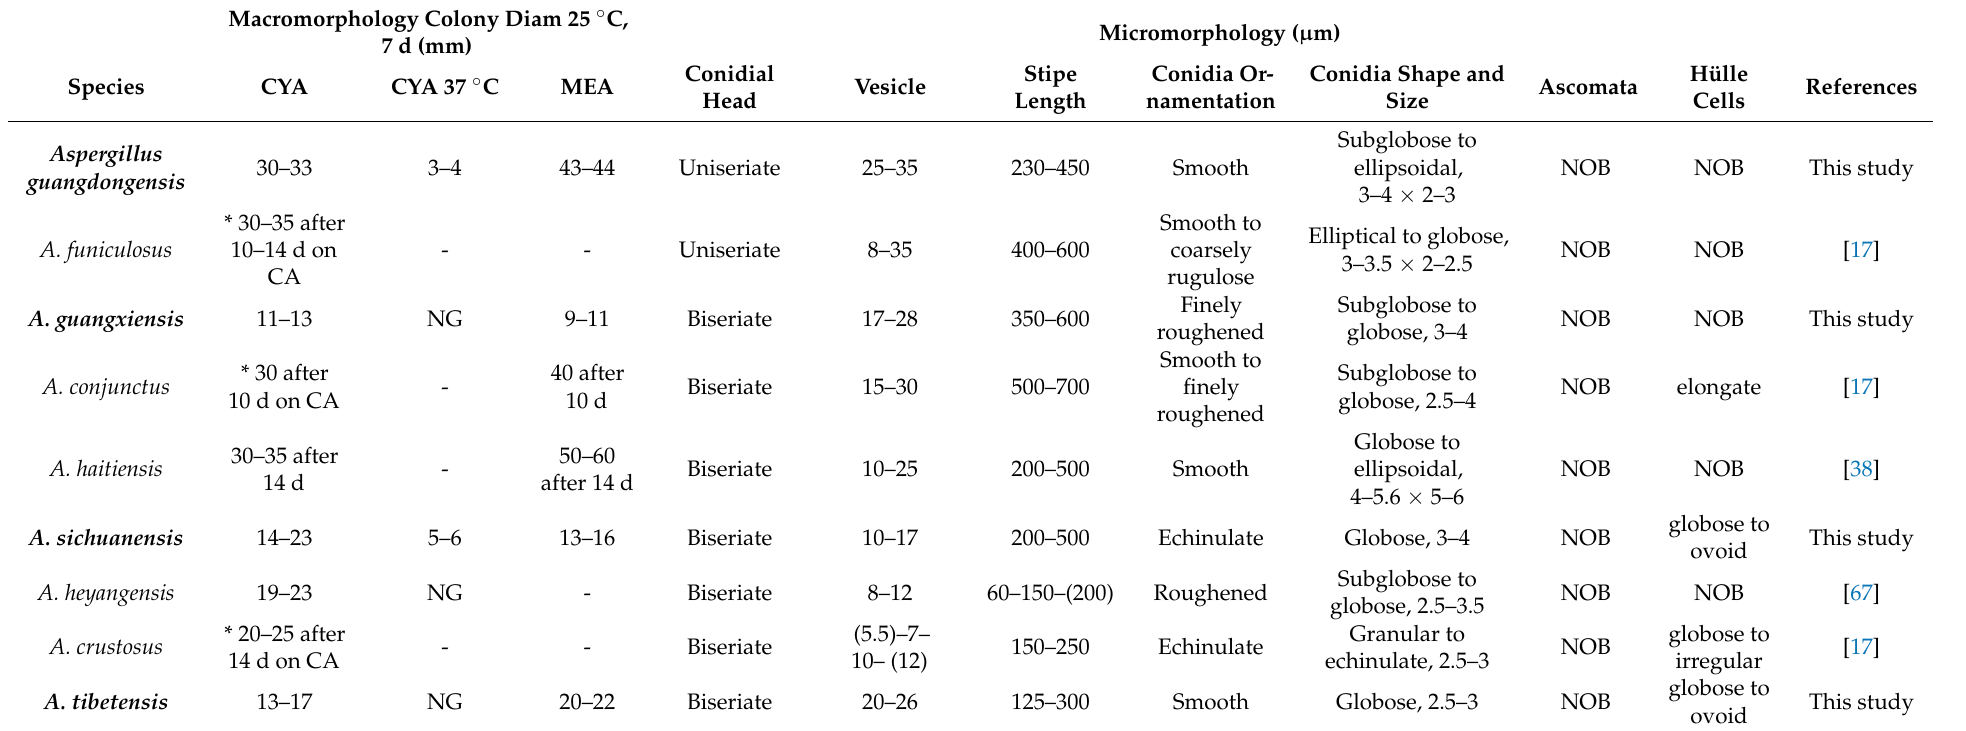
Table 2. Morphological comparisions of new species and their closely related